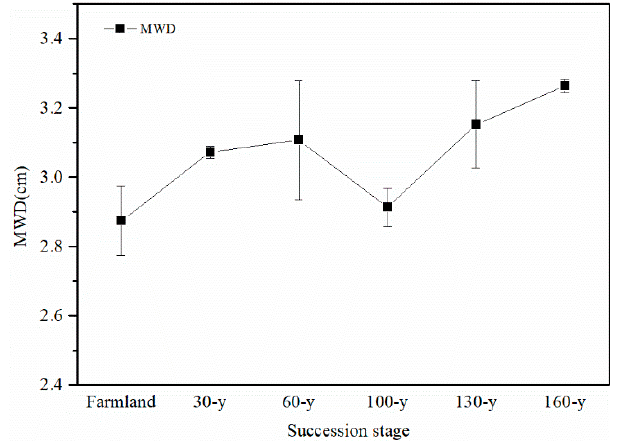
Figure 2. Changes in MWD in Surface layer with vegetation succession. 203